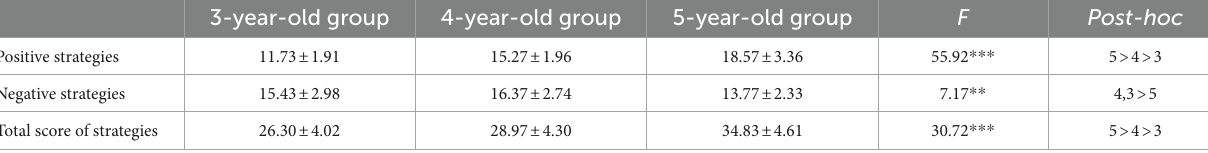
TABLE 2 Results of age difference on children’s peer conflict resolution strategies (M ± SD).